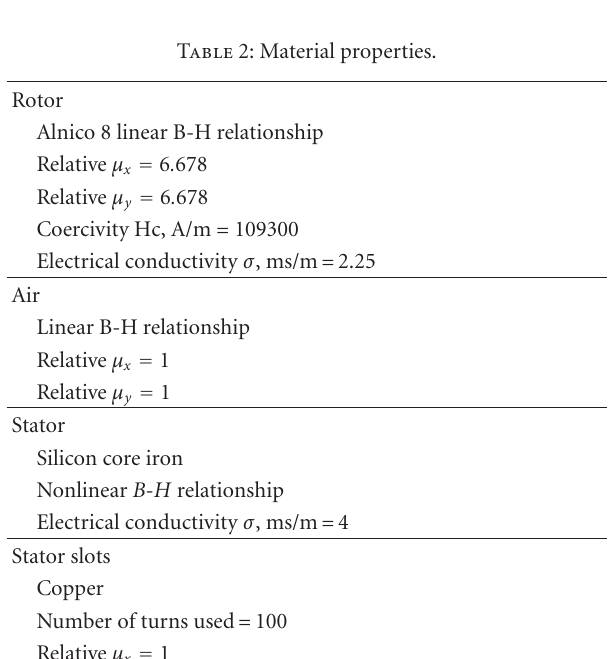
Figure 3: Flux plot.